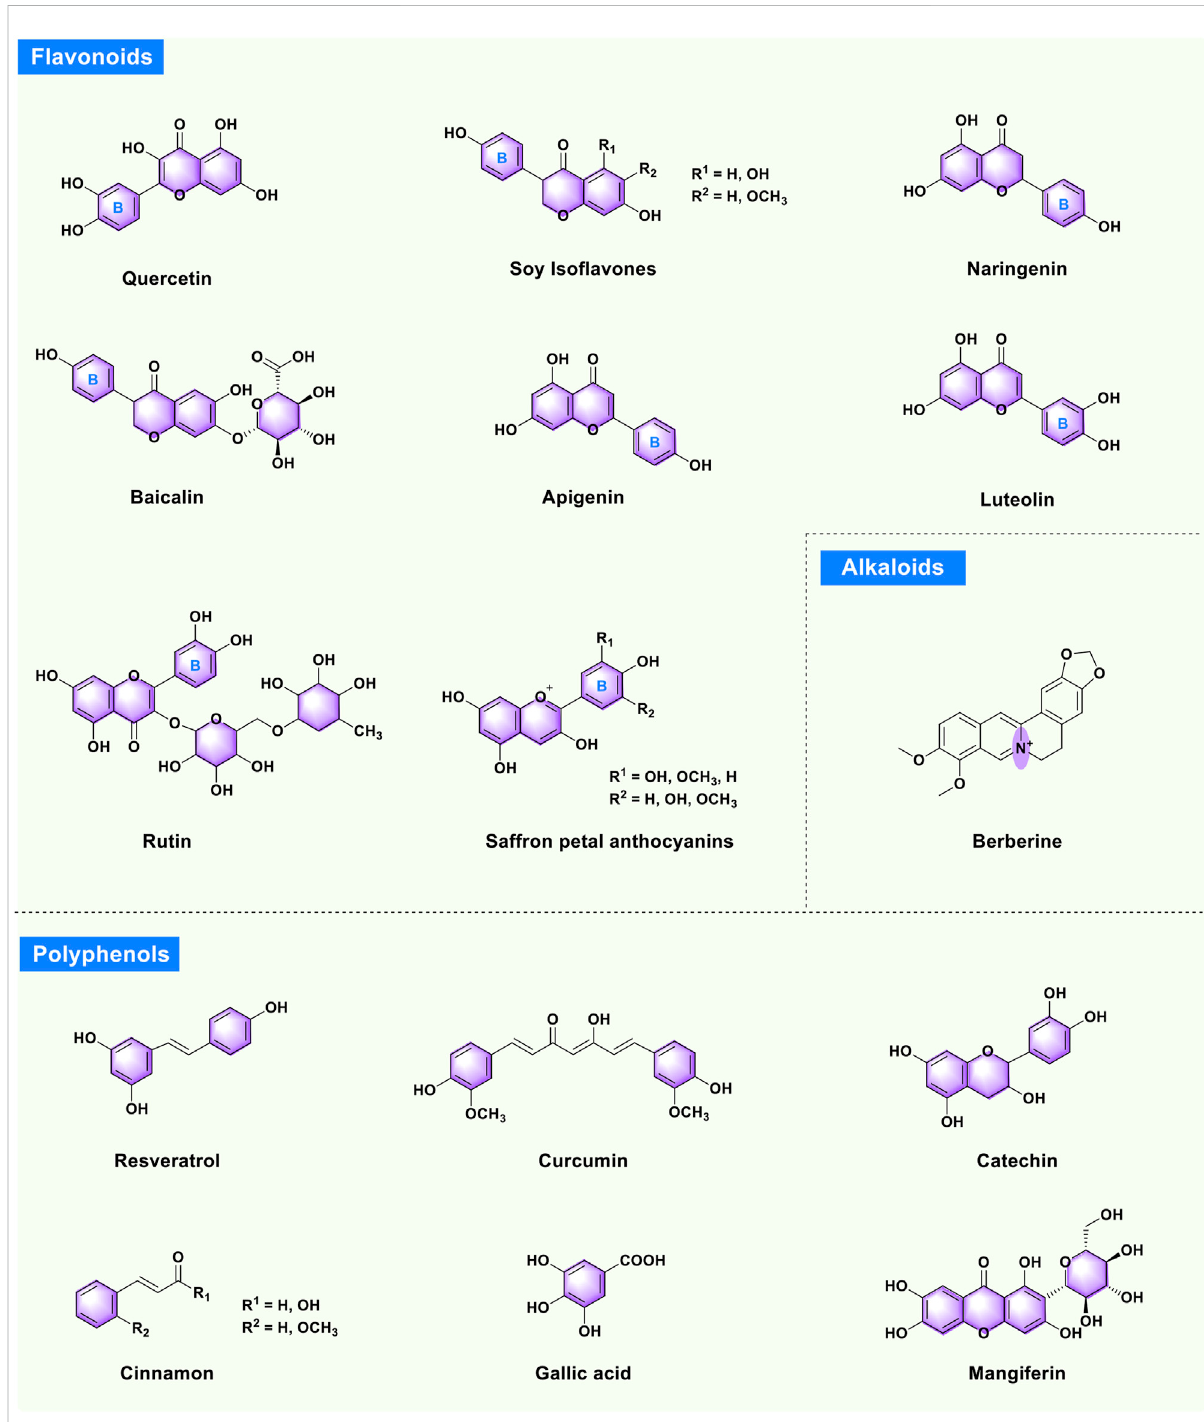
Bioactive phytochemicals isolated from TCM and medicinal plants forward